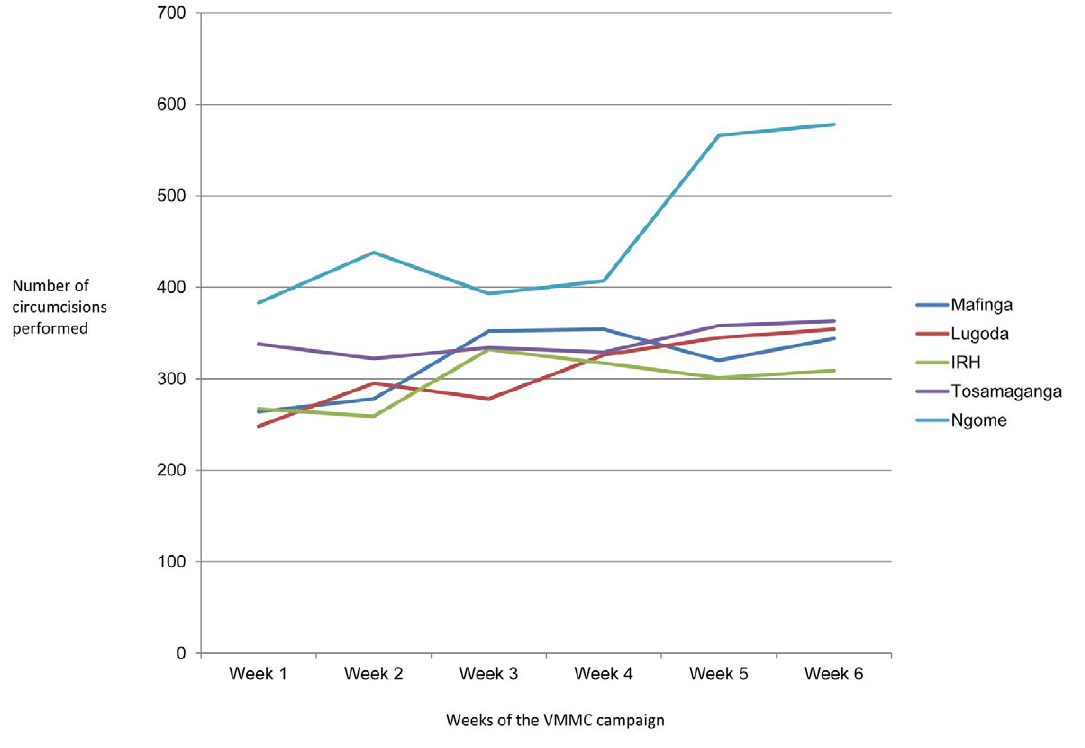
Figure 2. Site-specific upward trends in VMMC service delivery during the campaign. The substantial increase in VMMC delivery at Ngome Health Centre (uppermost line) was due to the addition of more surgical bays mid-campaign. IRH, Iringa Regional Hospital.